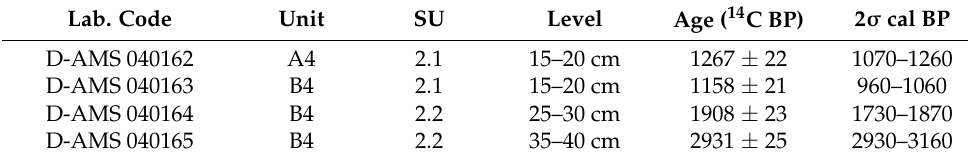
Table 3. Radiocarbon ( 14 C AMS) chronology for the La Tina rock shelter. Lab. Code Unit SU